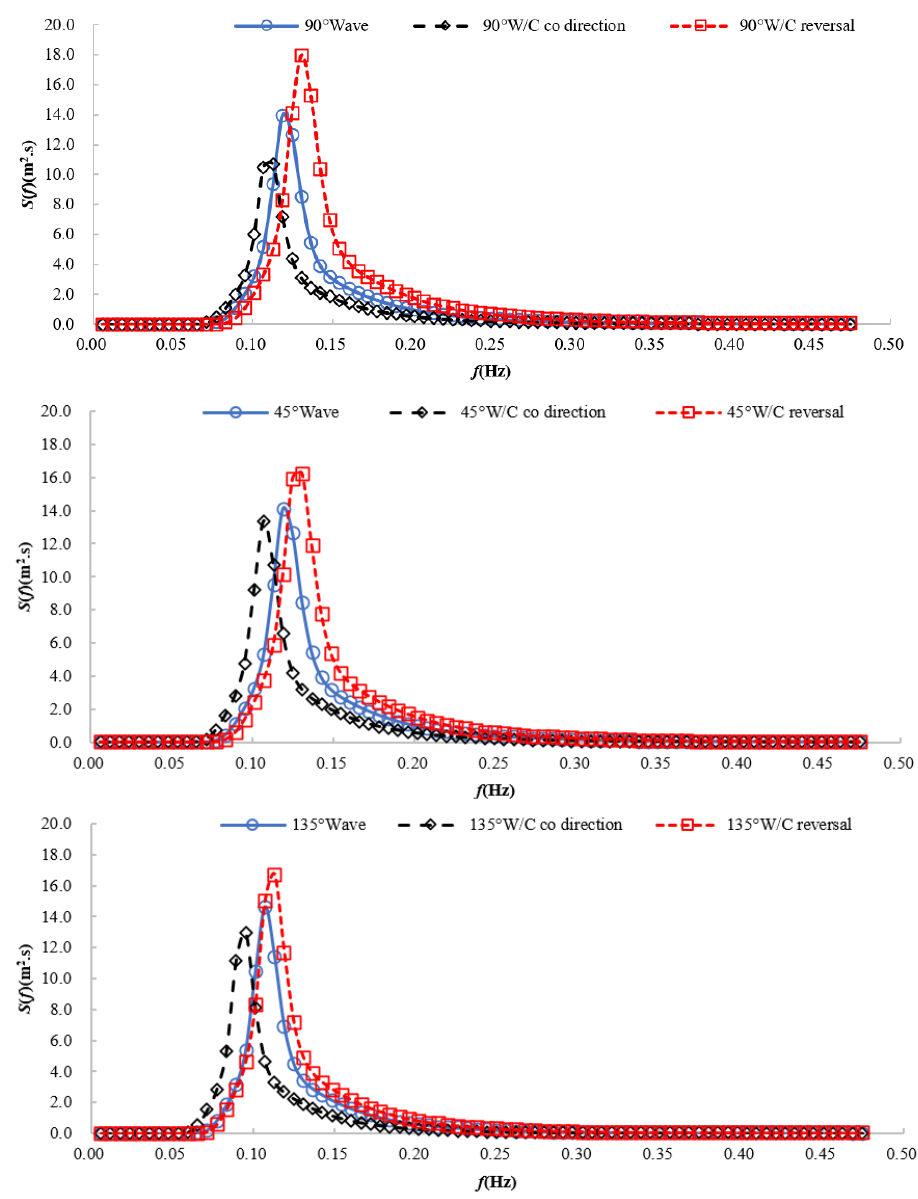
Figure 6. Comparison of wave spectrum before and after wave–current coupling at the junction of the island and tunnel.